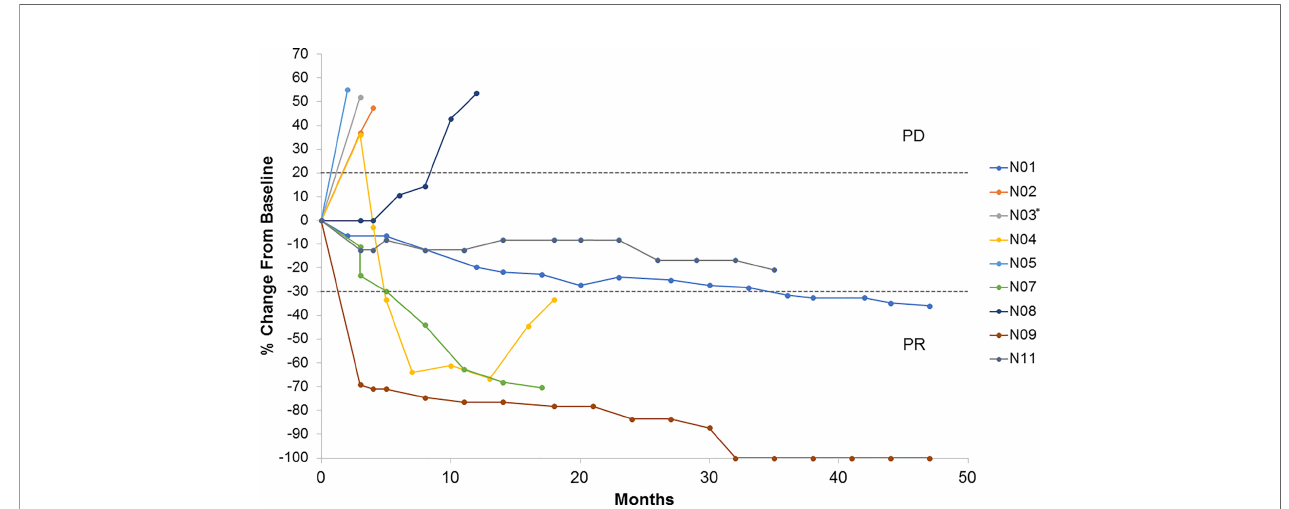
FIGURE 1 | Tumor growth by subject. Spider plot illustrating changes in target lesions from baseline in patients evaluable by RECIST v.1.1 ( N =9). *Patient N03 was non-evaluable at 12 weeks PR, partial response; PD, progressive